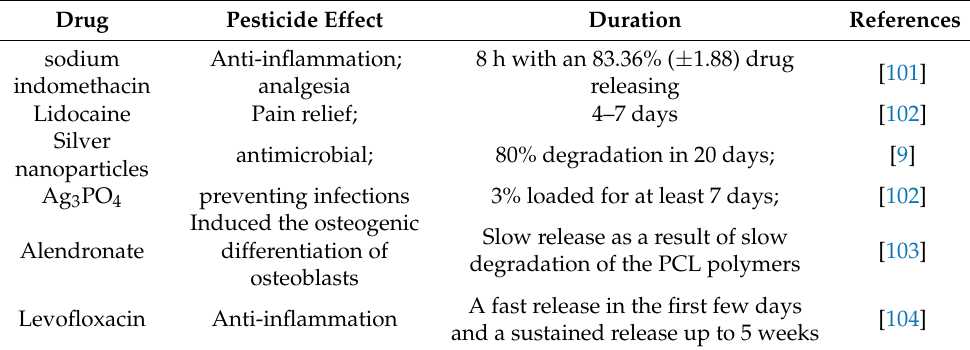
Table 4. A summary of drug loading in PCL-based composite scaffolds.